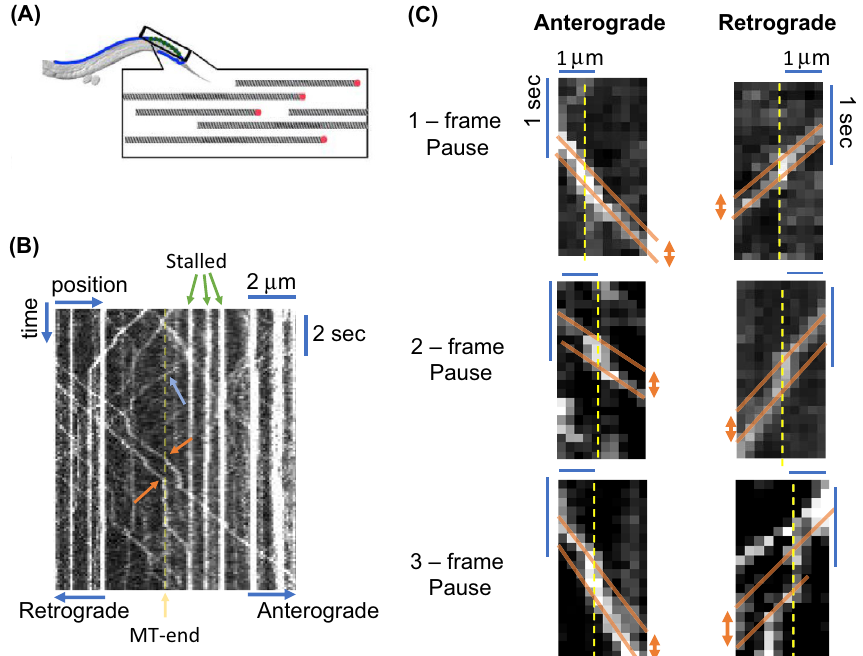
Figure 1. MT-end kymograph analysis method. ( A ) Cartoon geometry of C. elegans axon and microtubule network. The axon has multiple tracks of microtubules aligned parallel to each other with breaks between individual microtubules. Figure reproduced with permission from Yogev et al. 7 . ( B ) Kymograph (time/space) representation of SVPs navigating an axon. A microtubule end is designated as dashed-yellow line (determined by fraction of traverses as described in 2.2). Vesicles are marked as traversing (blue arrow) or pausing (orange arrow) at the end. Vesicles engage in both anterograde and retrograde motion. ( C ) Examples of quantification of short-time vesicle pausing at microtubule-ends (dashed yellow lines determined by fraction of traverses as described in 2.2). The pause-time at a MT-end is determined as the time difference between velocity traces (orange solid lines). Both anterograde and retrograde motion are quantified the same and exhibit the same pausing